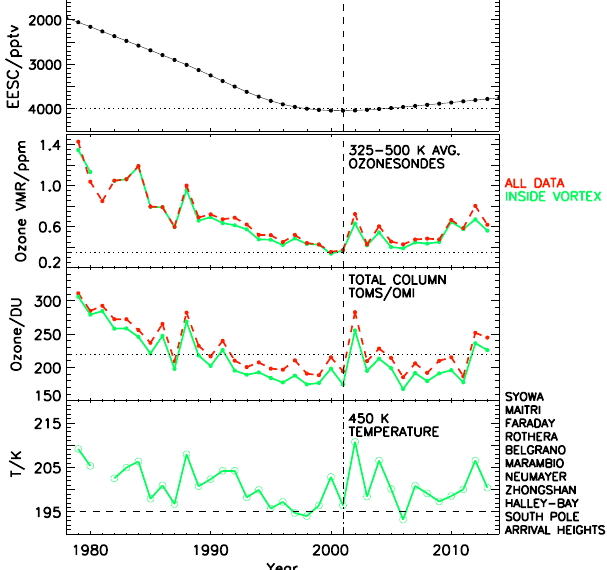
Figure 1. Time evolution of stratospheric halogens, ozone and temperature: Top: The temporal evolution of equivalent effective stratospheric chlorine (EESC) in the stratosphere in the inverted scale (with respect to the World Meteorological Organisation A1–2010 scenario). The horizontal line indicates 4000 pptv. Second from Top: Time evolution of the September, October and November (SON, spring) averaged ozone volume mixing ratios (VMRs) over the altitude range 325–500 K (~10–20 km) from ozonesonde measurements in the Antarctic. The horizontal line indicates 0.4 ppmv. Third from Top. The time evolution of the SON averaged total column ozone (TCO) measurements at selected Antarctic stations, as listed in the figure legend. The TCO measurements are taken by the Total Column Ozone Mapping Spectrometer (TOMS, 1979–2003) and Ozone Monitoring Instrument (OMI, 2004–2013). The horizontal line indicates 220 DU, the Antarctic ozone hole criterion. Bottom: The vortex-averaged temperature estimated at the ozonesonde stations in the Antarctic vortex in spring (SON). The horizontal dotted lines represent 195 K. The red curve shows all measurements without any vortex consideration (ALL DATA) and the green curve represents the measurements sorted inside the vortex with ≥ 65° S EqL criterion (INSIDE VORTEX). The vertical dashed line at 2001 in all plots represents the turnaround year of